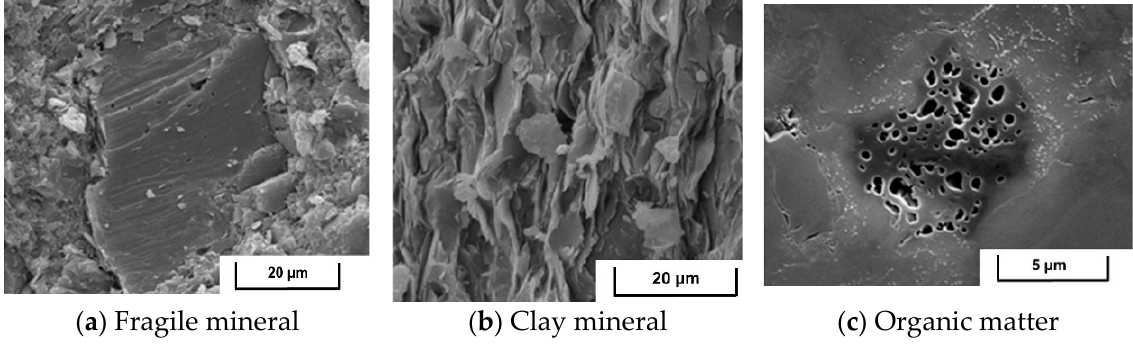
Figure 11. Scanned results of shale sample by electron microscope.